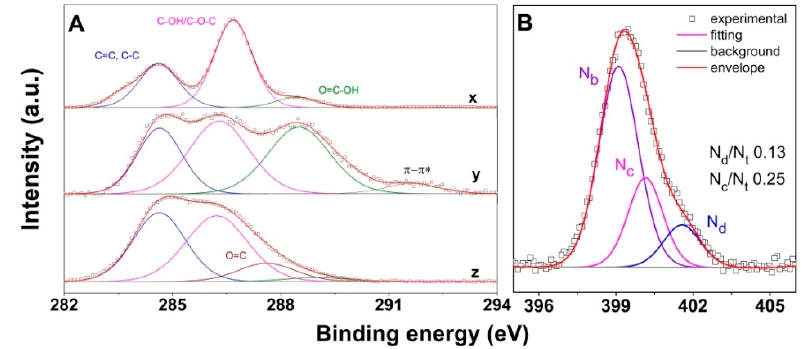
Figure 8. XPS C 1s spectra ( A ) for the higher oxidation degree GO before (x), and after carboxylation (y) and furthermore modification with EDA (z); N 1s spectra upon modification with EDA ( B ).